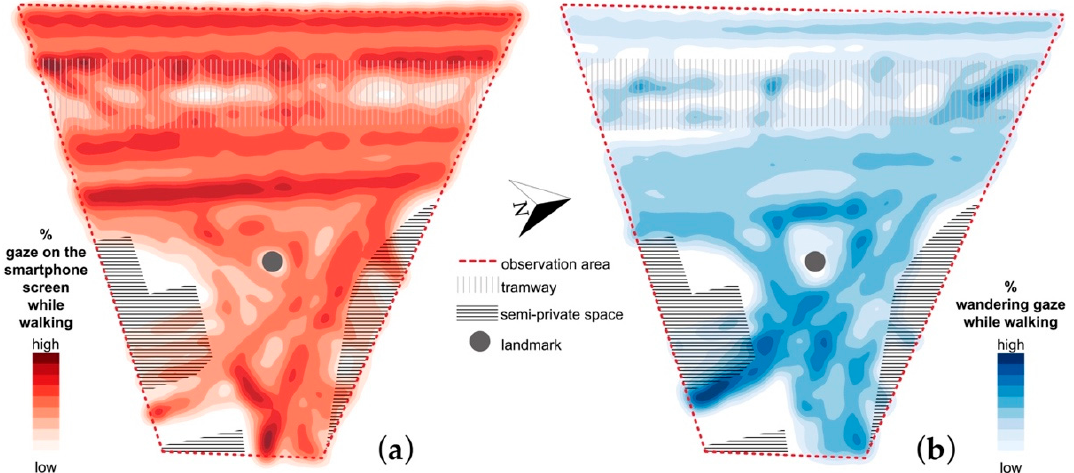
Figure 10. Heatmaps of the observation area that show the distribution of the routes of smartphone users according to ( a ) percentage of gaze on the smartphone screen, and ( b ) percentage of wandering gaze whilst walking. Maps were generated with the QGIS built-in heatmap renderer by using the quartic kernel shape function.